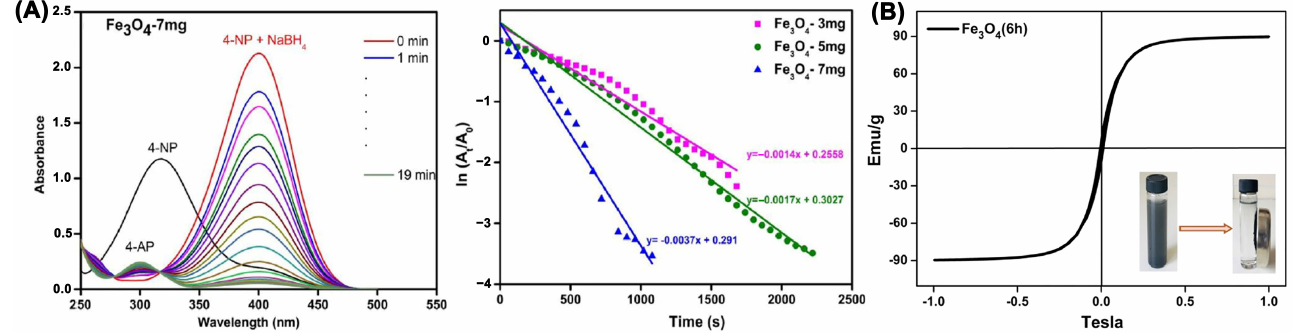
Figure 2. ( A ) UV–vis spectra obtained in the p -nitrophenol reduction in the presence of Fe 3 O 4 NPs (left figure) and rate constants of the reaction (right figure) [71], Copyright 2020 Elsevier; ( B ) hysteresis loops of Fe 3 O 4 nanoparticles [72], Copyright 2021 Springer.